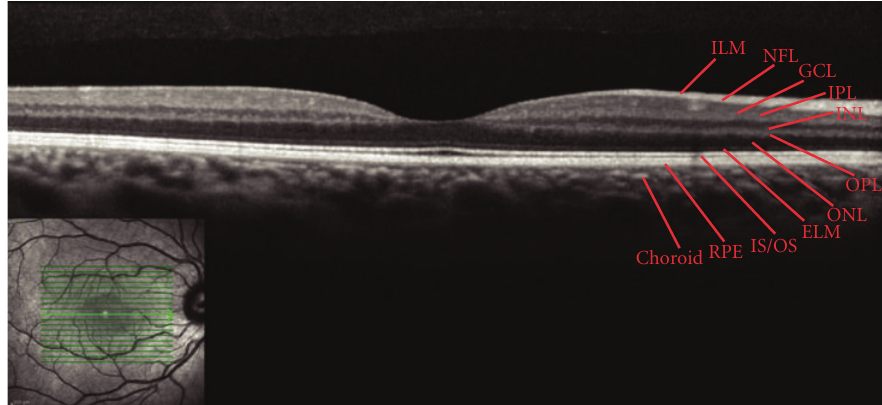
Figure 1: Example of a normal eye imaged with the Spectralis SDOCT. The infrared reflectance cSLO image (lower left) shows a normal fundus which corresponds to the normal SDOCT B-scan. The green lines represent the location, and the green arrow shows the exact orientation of the B-scan. All the retinal layers are indicated on the SDOCT scan (ILM: internal limiting membrane; NFL: nerve fiber layer; GCL: ganglion cell layer; IPL: inner plexiform layer; INL: inner nuclear layer; OPL: outer plexiform layer; ONL: outer nuclear layer; ELM: external limiting membrane; IS/OS: photoreceptor inner/outer segment junction; RPE: retinal pigment